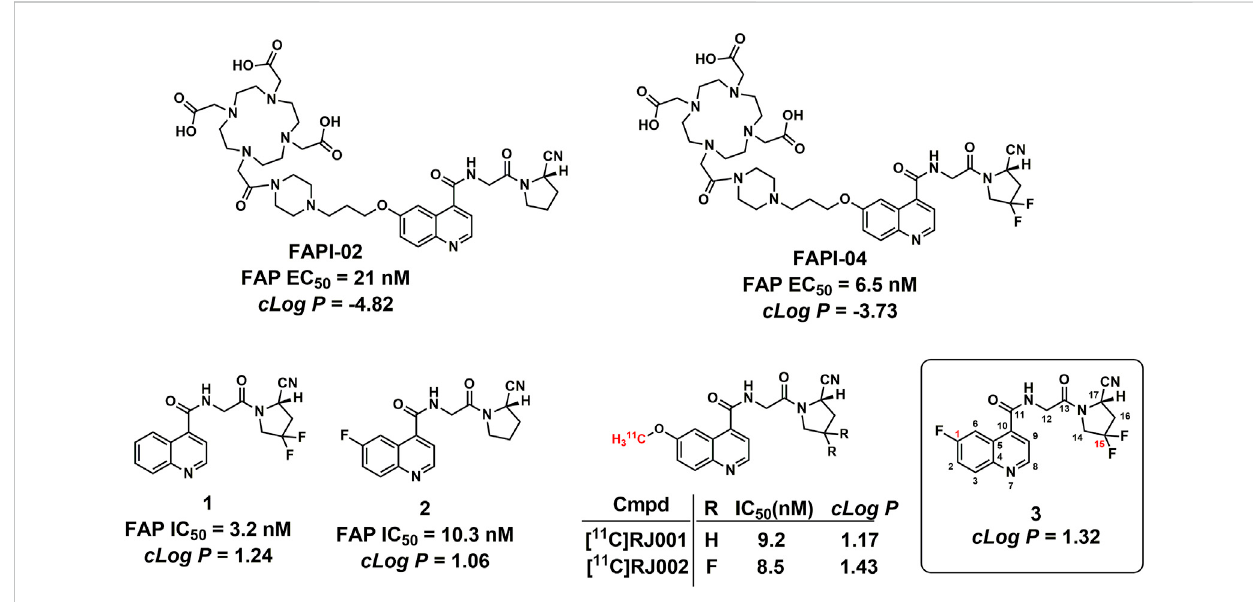
FIGURE 1 Structures of the representative FAPI PET tracers and compound 1. IC 50 values for FAP-02, FAP-04, and compounds 1 and 2 were obtained from published literature reports (Jansen et al., 2013; Jansen et al., 2014; Lindner et al.,